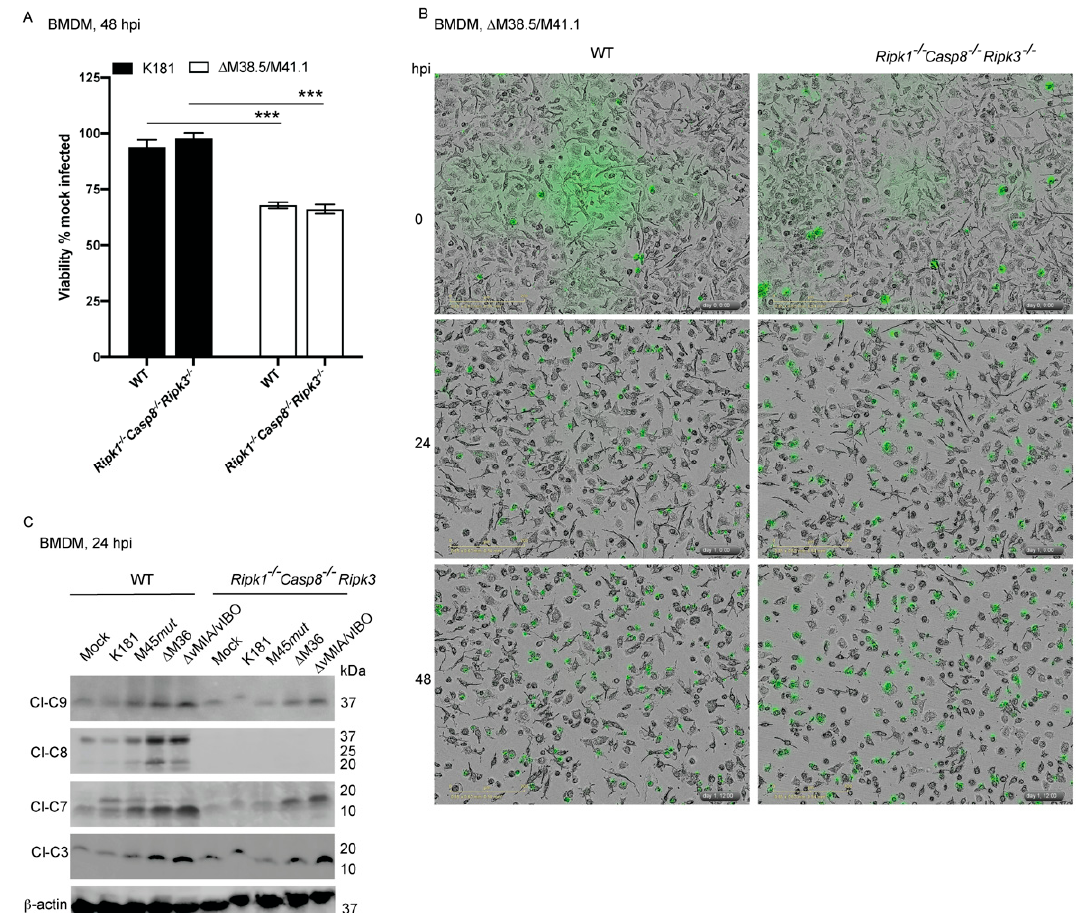
Figure 4. Ripoptosome and mitochondrial stress. ( A ) Viability of WT or Ripk1 − / − Casp8 − / − Ripk3 − / − BMDM infected with K181 or ∆ M38.5/M41.1 (MOI = 10) assessed by the loss of ATP at 48 hpi. Each bar represents the pooled data from at least three experiments. Horizontal lines indicate the two groups being compared by Wilcoxon matched-pairs signed rank test. Only significant relevant comparisons are indicated in panels. Error bars indicate standard error and mean for each dataset. *** is p < 0.001. ( B ) Representative light microscopy images (lower left scale bar = 200 mM) of WT or Ripk1 − / − Casp8 − / − Ripk3 − / − BMDM infected with indicated viruses at indicated times. Time stamp from the microscope is included in the lower-right corner of each image. ( C ) Immunoblot assessment to detect the appearance of cleaved forms of CASP9 (Cl-C9; ~37 kDa), CASP8 (Cl-C8; 43 and 18 kDa), CASP7 (Cl-C7; 18 kDa), and CASP3 (Cl-C3; 17 kDa) in cellular protein lysates from Casp8 − / − Ripk3 − / − BMDM treated with medium (mock) or infected with the indicated viruses. β -actin (38.5 kDa) serves as the loading